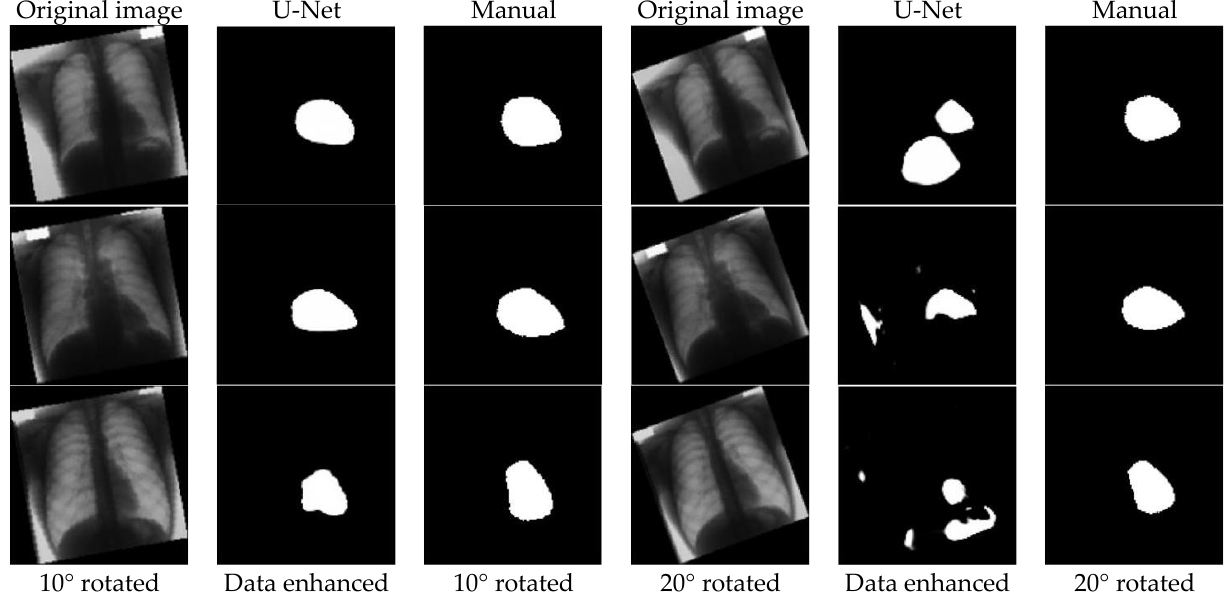
rotated images in the test database. The results are shown in Figure 9.